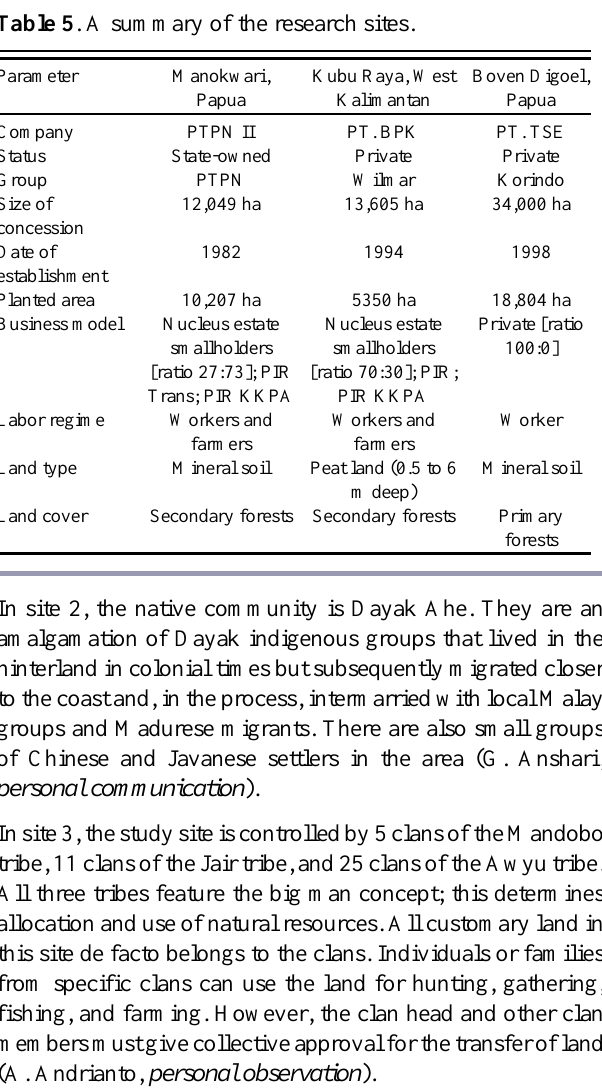
Fig. 2 . Land cover change analysis for site 1 at three points in time: (a) 1972/82 (prior to plantation establishment); (b) 1989/91; and (c)